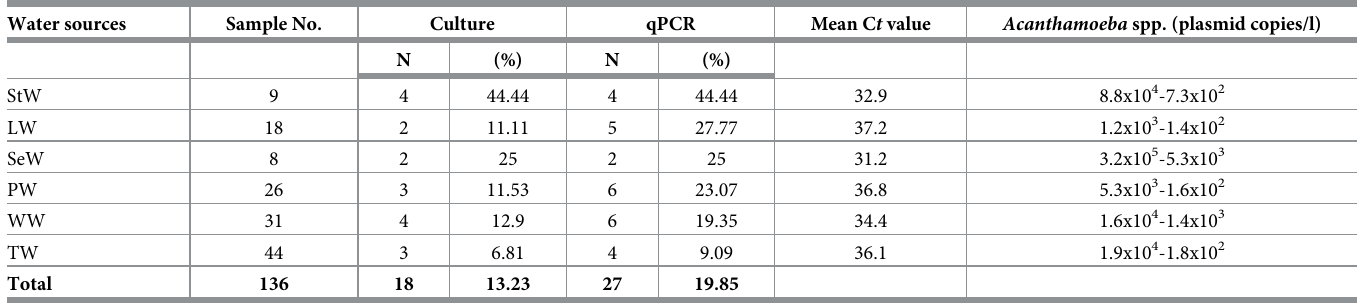
Table 1. Result of the qPCR assay and culture for Acanthamoeba spp. in various waters sources. Water sources Sample No.